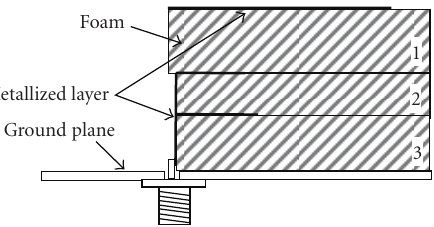
Figure 11: Structure of the antenna using metallized foam technol- ogy.